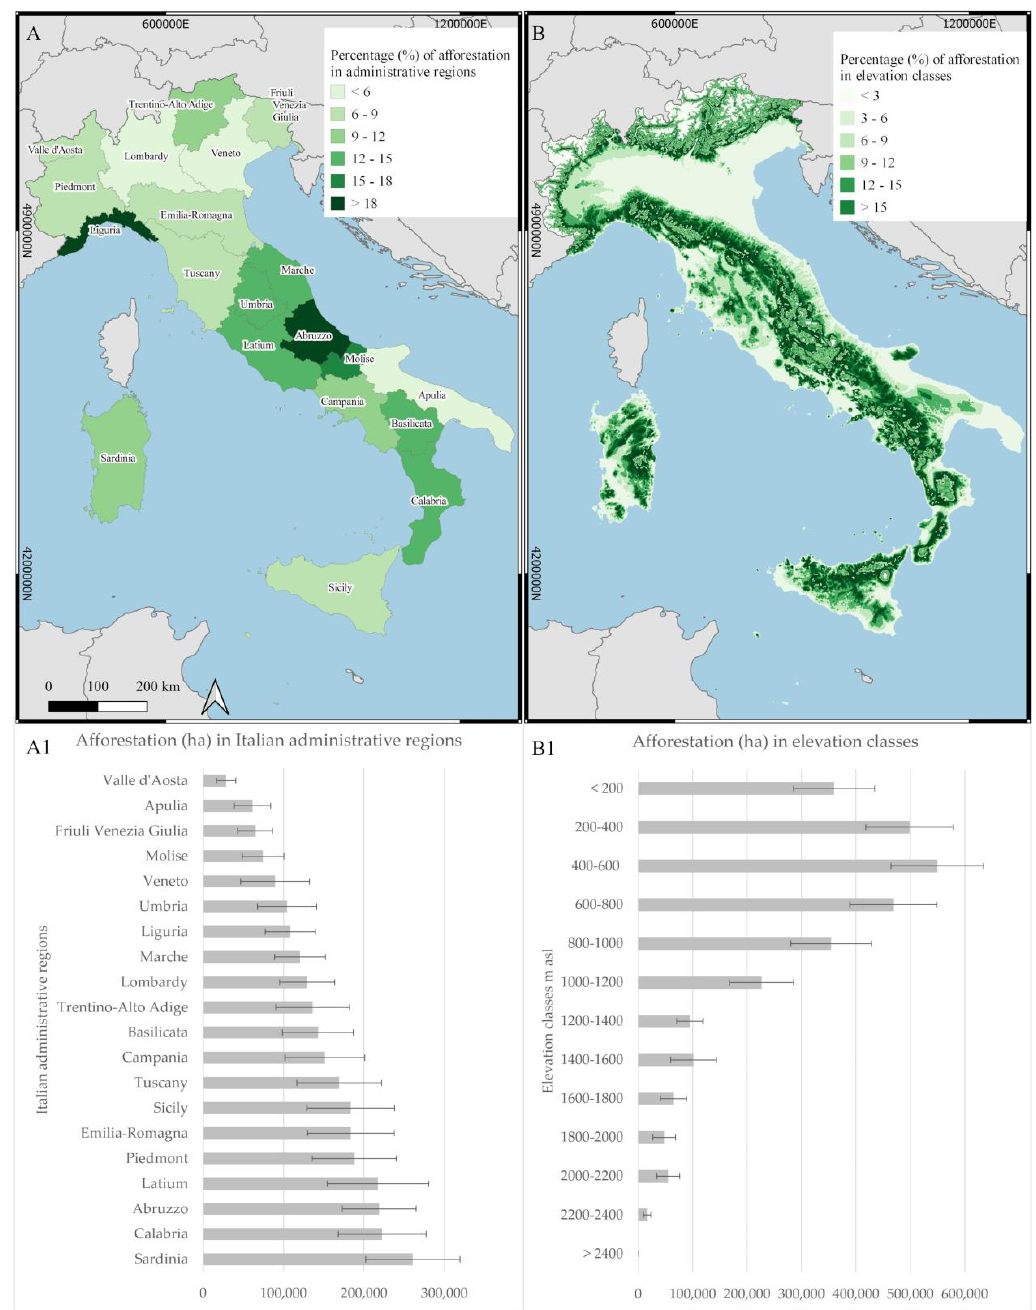
Figure 4. The upper maps depict the percentage of afforestation (1985–2019) in each Italian admin- istrative region ( A ) and in each elevation class ( B ). The lower graphs report the afforestation area estimates and corresponding 95% confidence intervals (ha) (1985–2019) in Italian administrative regions ( A1 ) and in each elevation class ( B1 ). CRS, WGS84/UTM Zone 32N. The estimated afforestation area estimates for the elevation classes and at the national level are illustrated in Figure 4B,B1 and Table A4 in Appendix C. The largest afforestation area between 1985 and 2019 was estimated in the intermediate elevation classes. Below 1200